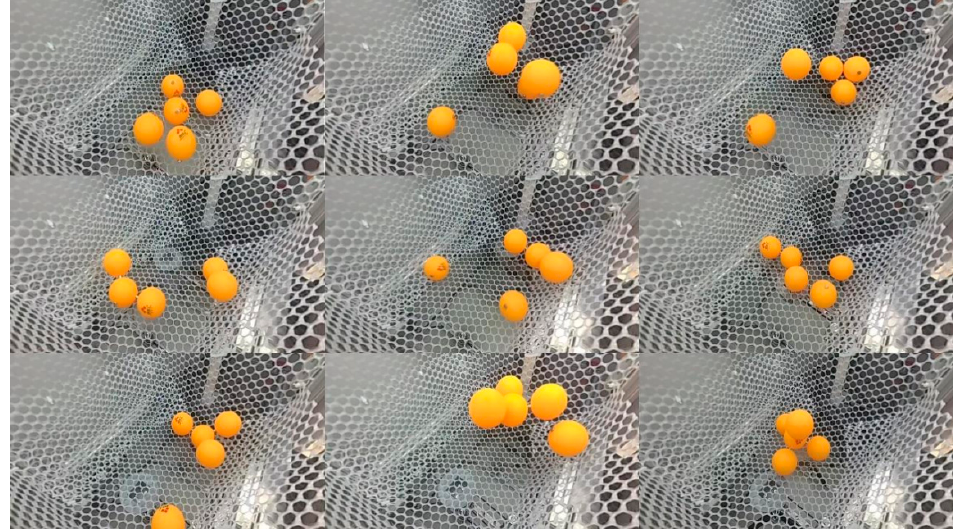
Figure 3. The assembly process of four sub-balls during a changing airspeed.